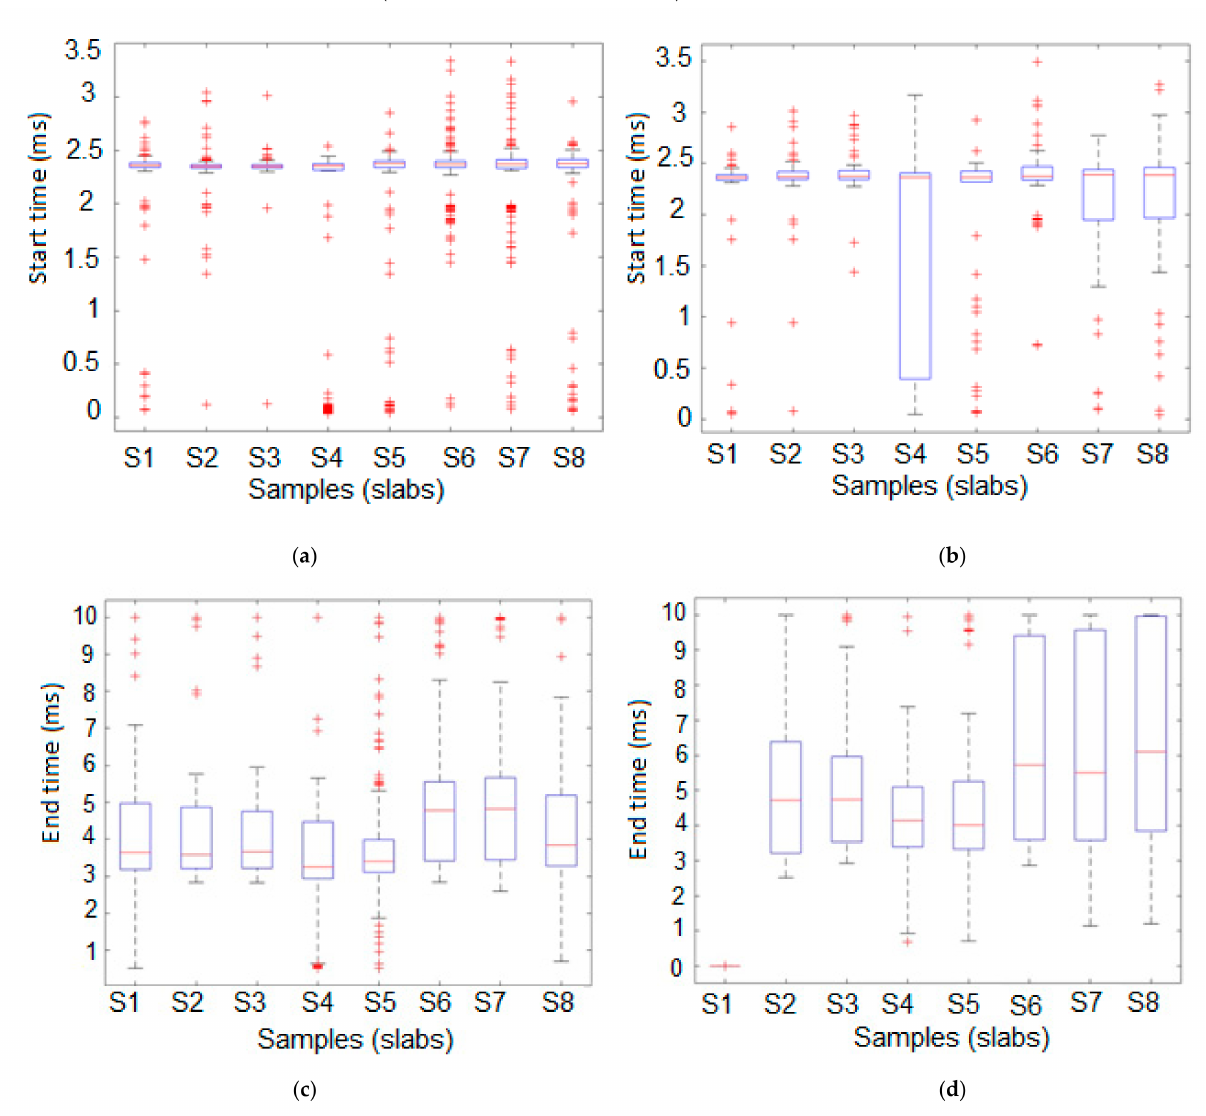
Figure 9. Box plot for the preprocessed IE signals’ ( a ) start time for sound group, ( b ) start time for defect group, ( c ) end time for sound group, ( d ) end time for defect